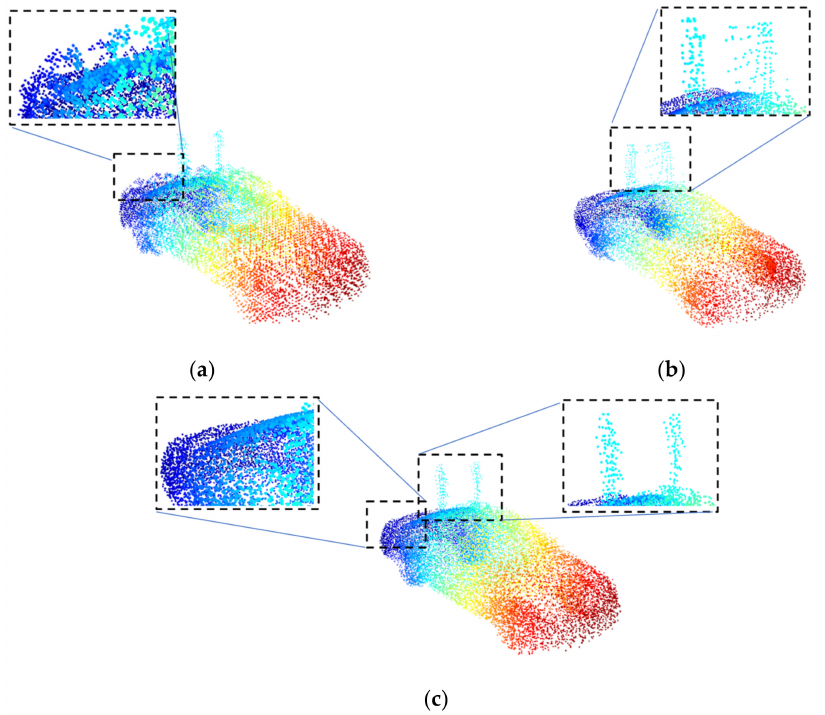
Figure 7. Visualization results for different neighborhood radii. The radius of ( a ) is too large, ( b ) too small, ( c ) applicable.